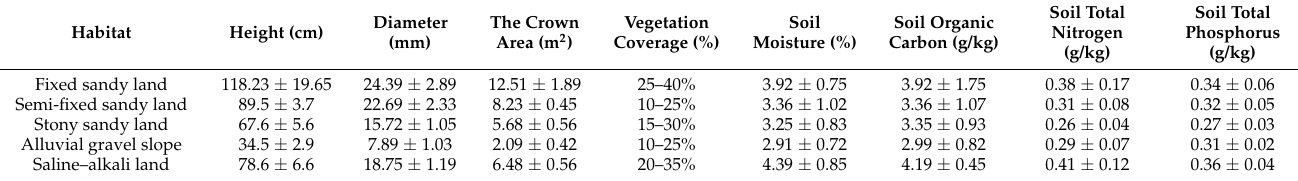
Table 2. Plot basic characteristics of A. mongolicus in different